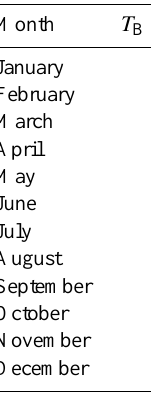
Table 3. A summary of the monthly brightness temperature thresh- olds used to screen cloudy-sky scenes from the AIRS